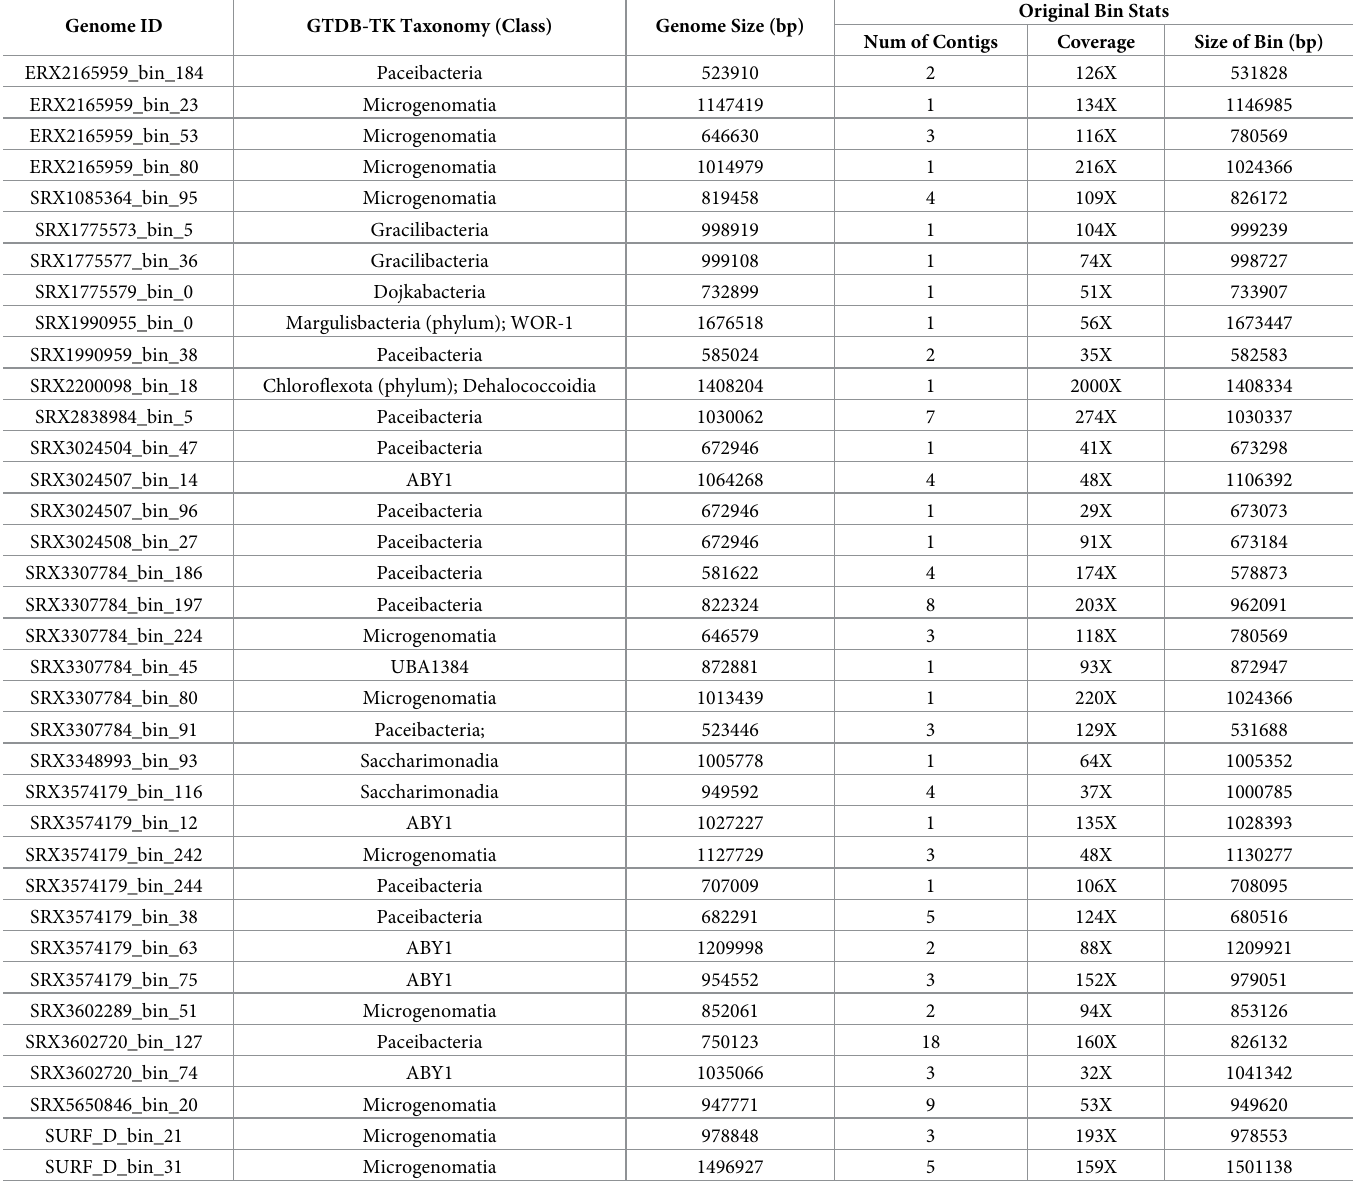
Table 2. List of 36 circularized bacterial genomes in this study. Genome